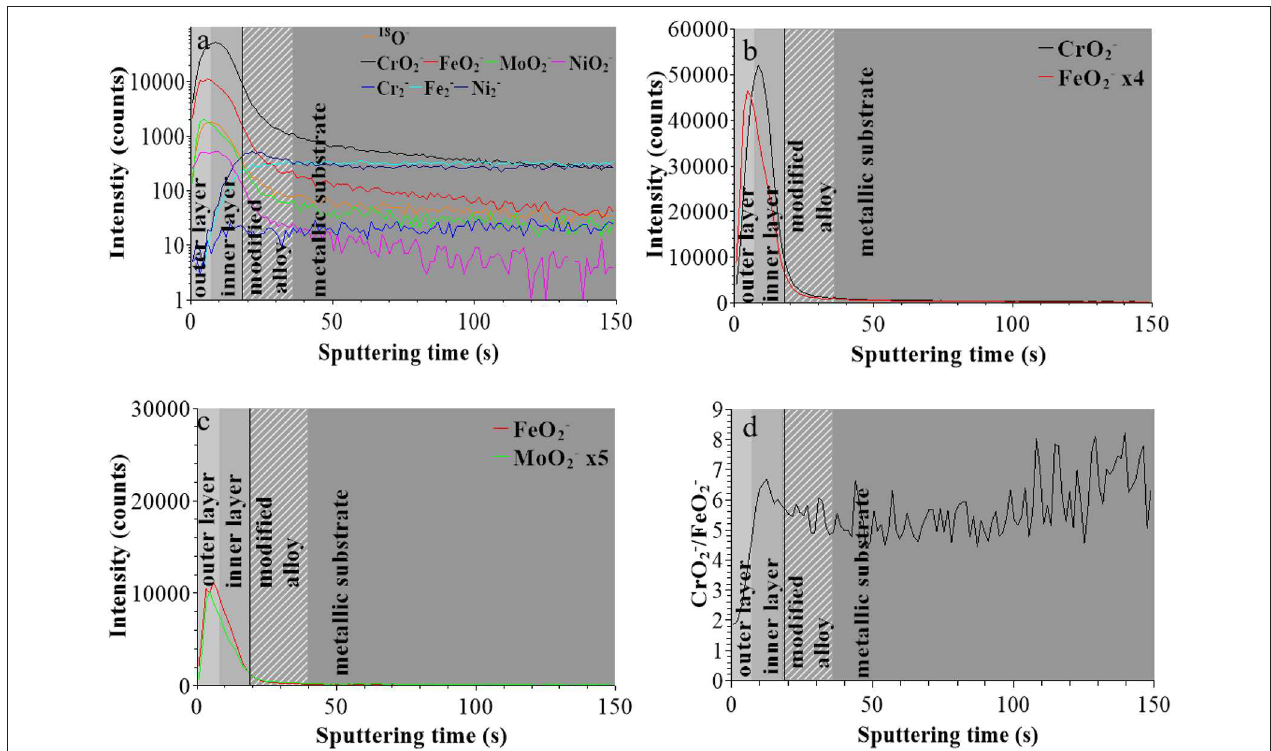
FIGURE 4 | ToF-SIMS depth profiles for 316L SS passivated in 0.05M H 2 SO 4 at U PASS = 0.5 V/SCE for 30 min: (a) 18 O − , CrO − 2 , FeO − 2 , NiO − 2 , MoO − 2 , Cr − 2 , Fe − 2 , and Ni − 2 secondary ions, (b) CrO − 2 and FeO − 2 secondary ions, (c) FeO − 2 and MoO − 2 secondary ions, (d) CrO − 2 / FeO − 2 intensity